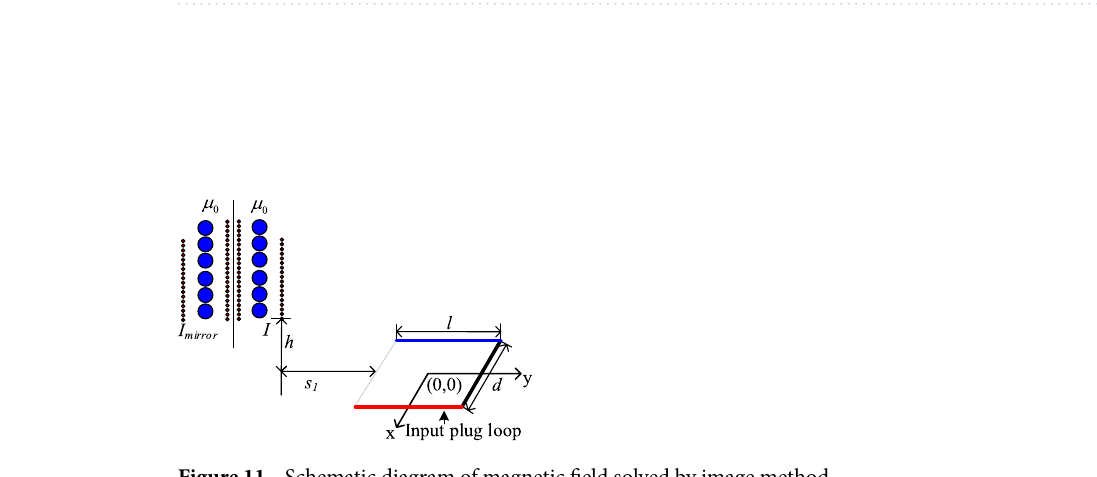
Figure 11. Schematic diagram of magnetic field solved by image